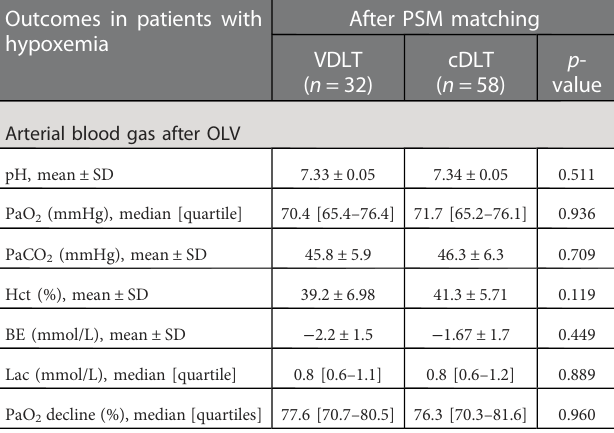
TABLE 3 VDLT vs. cDLT: outcomes in patients with hypoxemia (after PSM matching). Outcomes in patients with